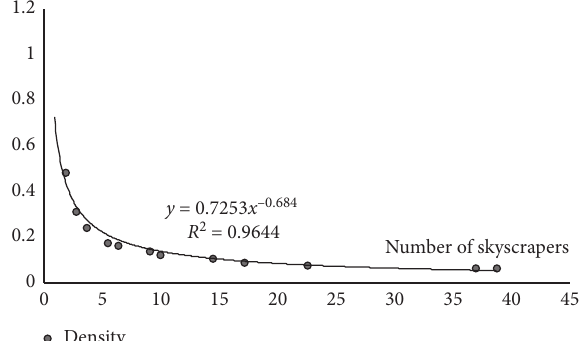
Figure 7: The relationship between network density and the number of